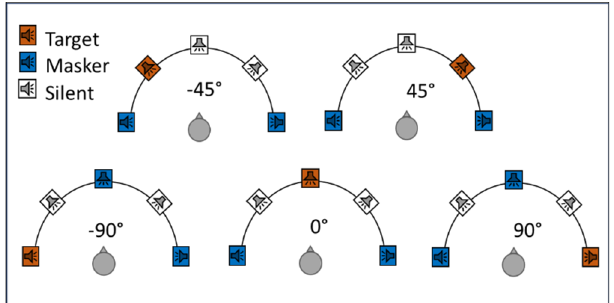
Figure 1. Speakers’